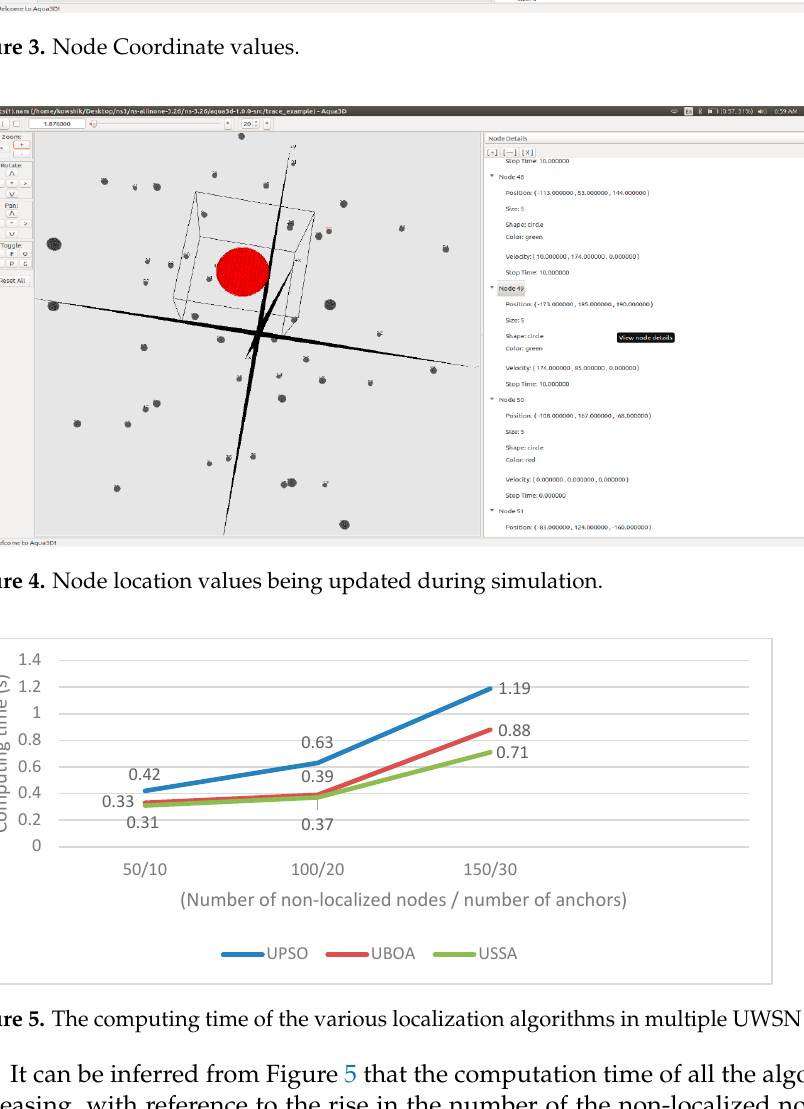
Figure 3. Node Coordinate values.